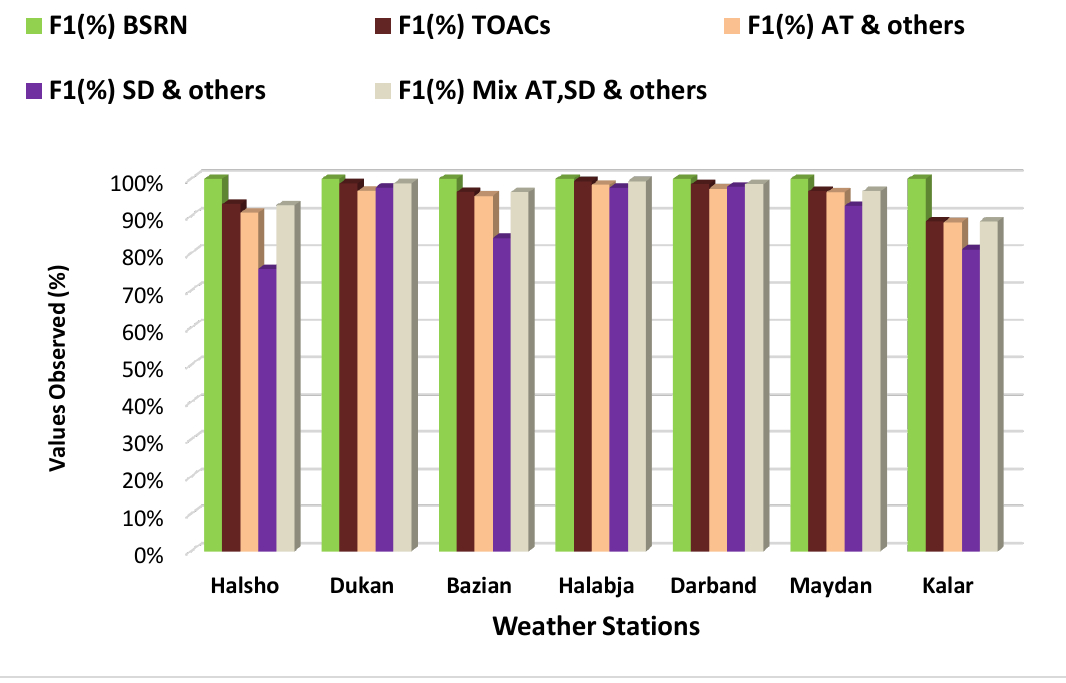
Figure 7. Bar chart of flag 1 passed data according to each set of tests in automatic stations.